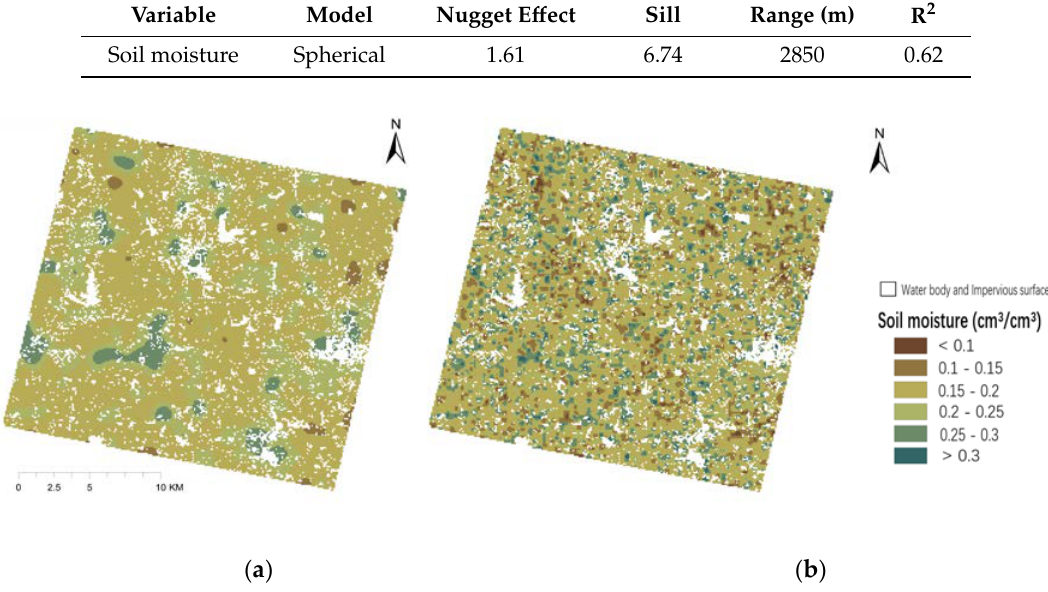
Figure 7. Maps of soil moisture based on the ordinary kriging (OK) method and BME framework: ( a ) OK method, ( b ) BME framework.